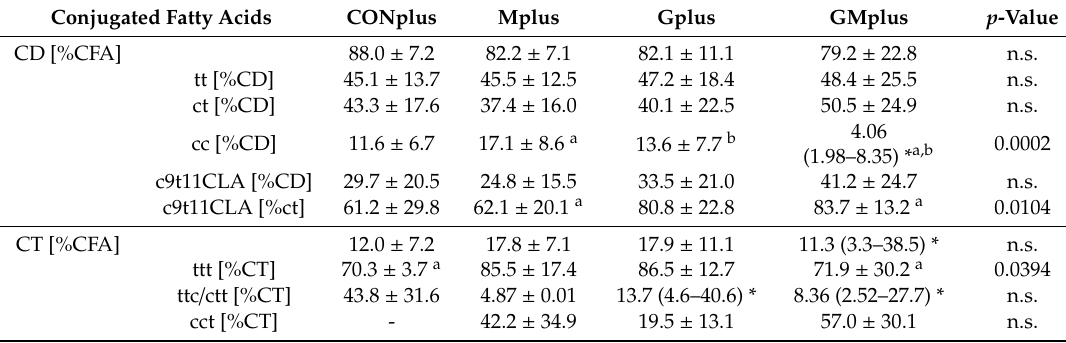
Table 5. CFA profile of mammary tumours of experimental